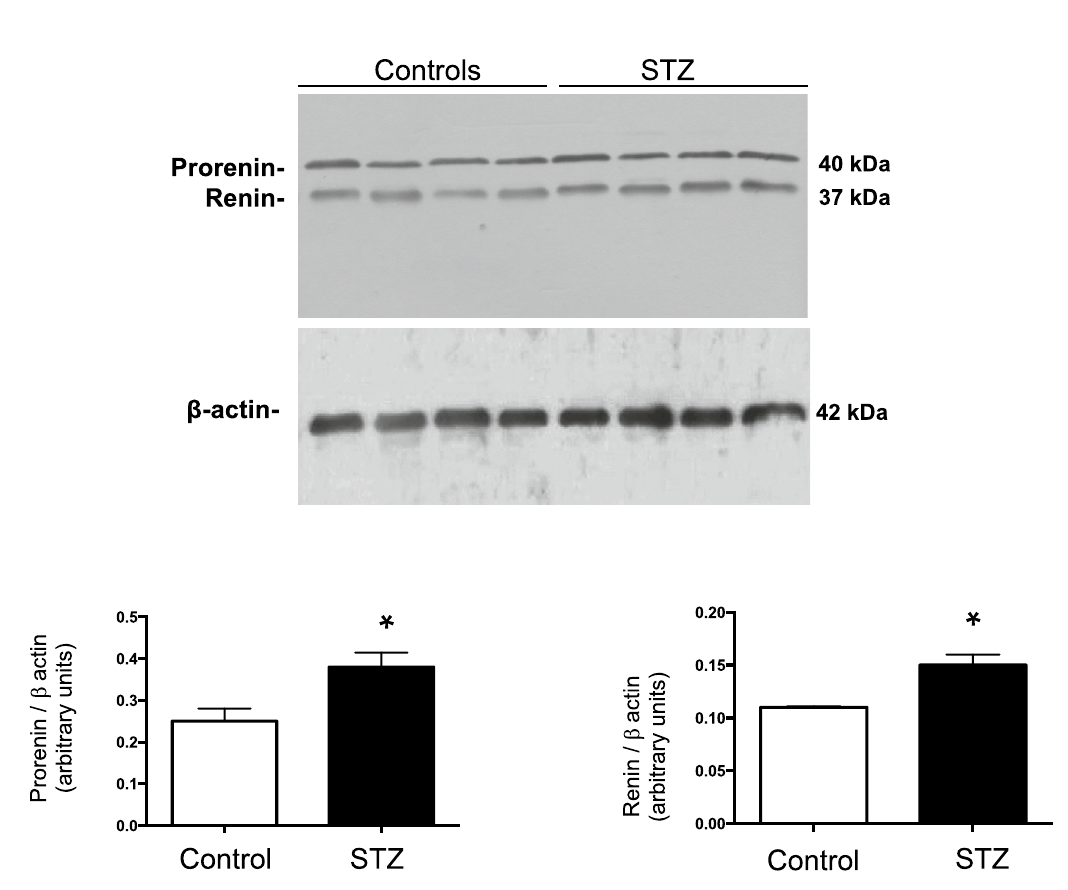
Figure 2. Prorenin and renin in the renal medulla. Representative immunoblots (controls n = 4 and STZ, n = 4) showing prorenin and renin protein levels in renal medullary tissues from control and STZ